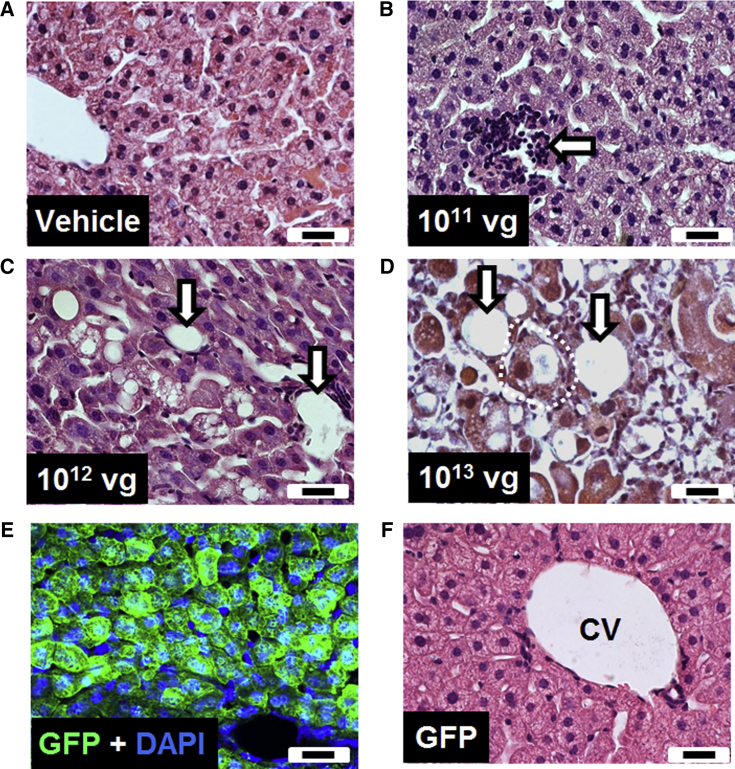
Intravenous Injection of the First-Generation Vector Resulted in Pathological Changes in the Liver(A–D) Representative H&E-stained liver sections from WT mice injected with (A) vehicle or (B–D) different doses of vector. (E) Liver section from a mouse injected intravenously with a GFP control vector, counterstained with DAPI. (F) Representative H&E-stained liver section from a GFP vector-treated mouse. Arrows indicate mononuclear cell infiltration, vacuolation, and/or loss of hepatocytes. Dashed white line indicates cellular swelling. Scale bars indicate 20 μm. CV, central vein.